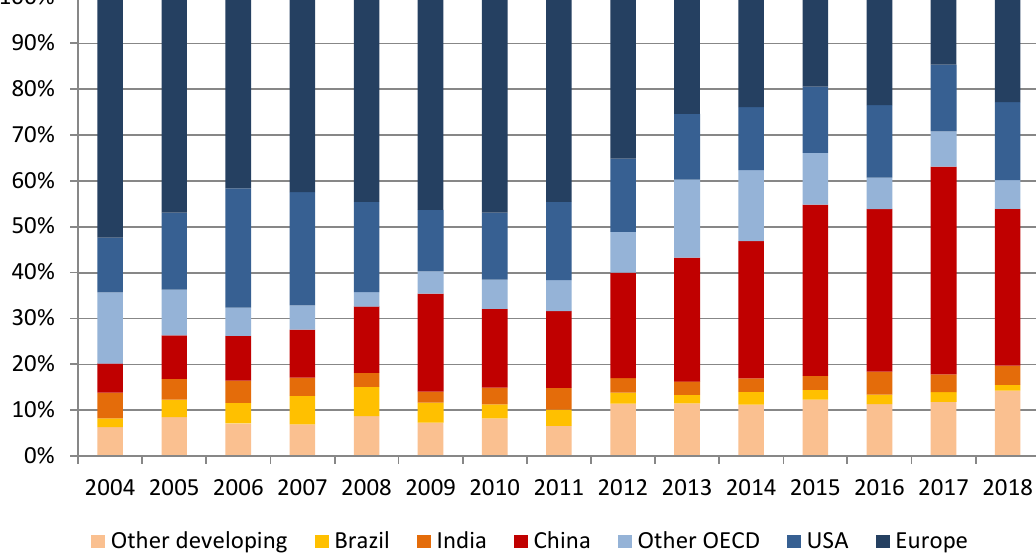
Figure 3 : Share of investment in renewable energy by country / group of